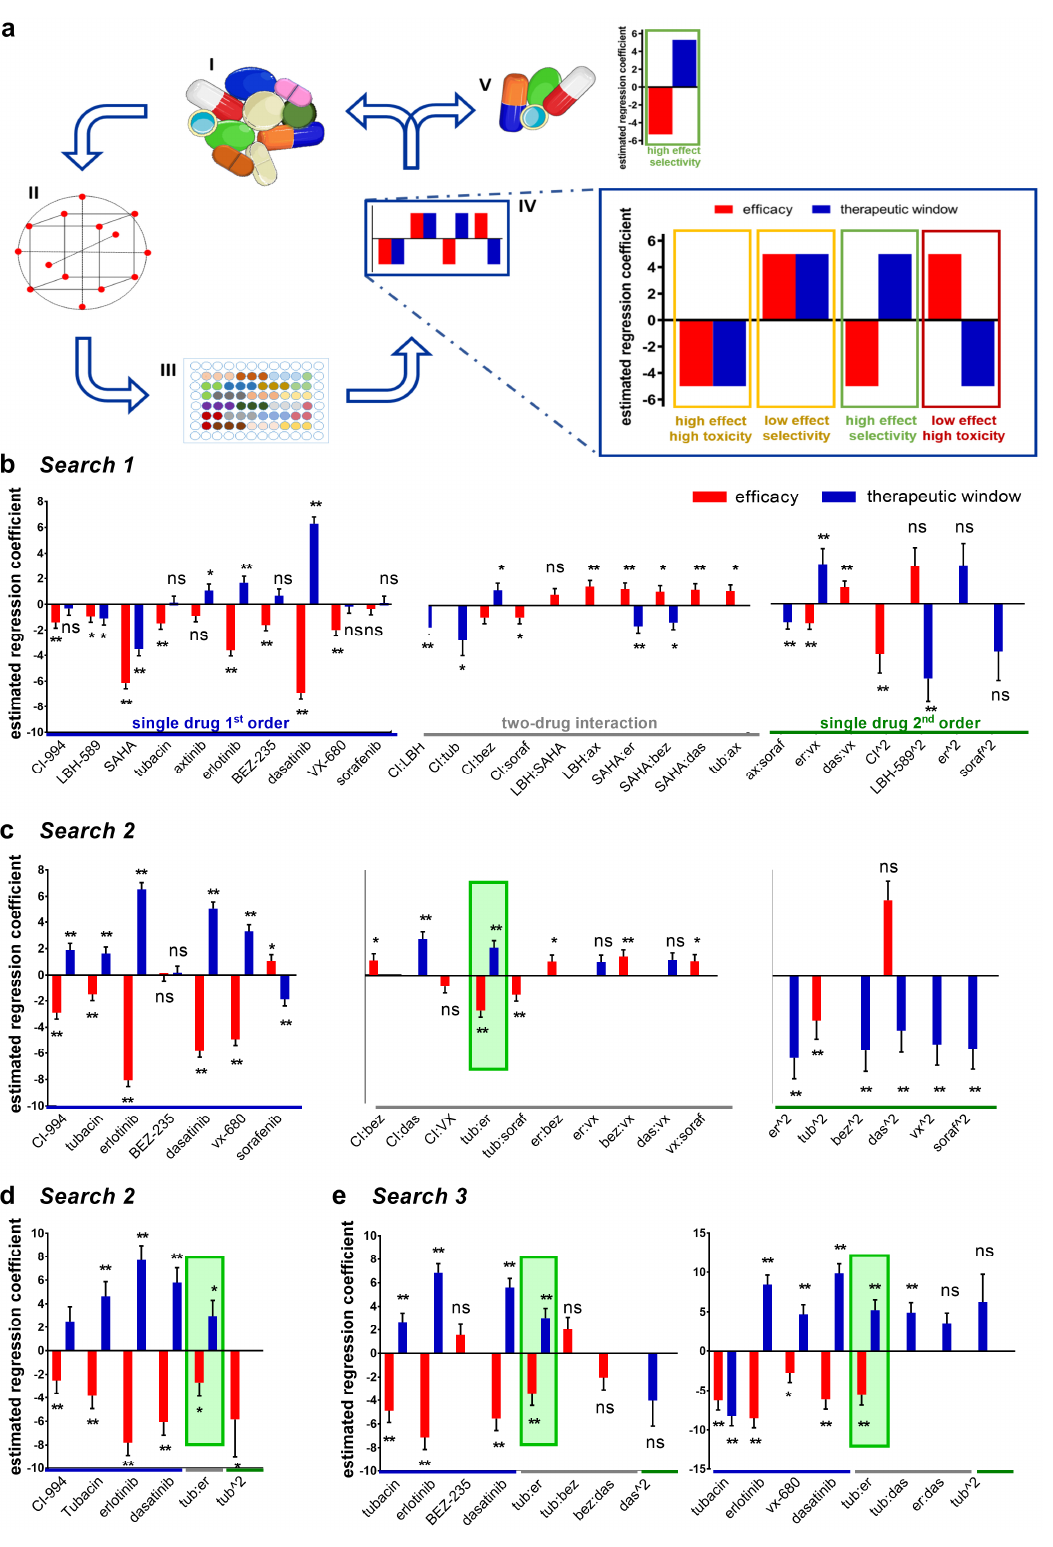
Figure 1. Therapeutically Guided Multidrug Optimization (TGMO)-based optimization of the drug combination. ( a ) Schematic overview of the TGMO-based optimization platform. (I) An initial set of ten drugs was selected. (II) Dose-response curves for each of ten drugs were generated for each cell type using inhibition of cell metabolic activity (ATP levels) as a measure for cell viability. The drug combination matrix to be tested was selected via an orthogonal array composite design (OACD). (III) The TGMO-based screen was initiated by experimentally testing a matrix of 91 drug combinations according to the drug combination matrix. (IV) The difference in drug efficacy between nonmalignant HEK-293T cells and malignant 786-O cells (in red) are defined as the therapeutic window (in blue).